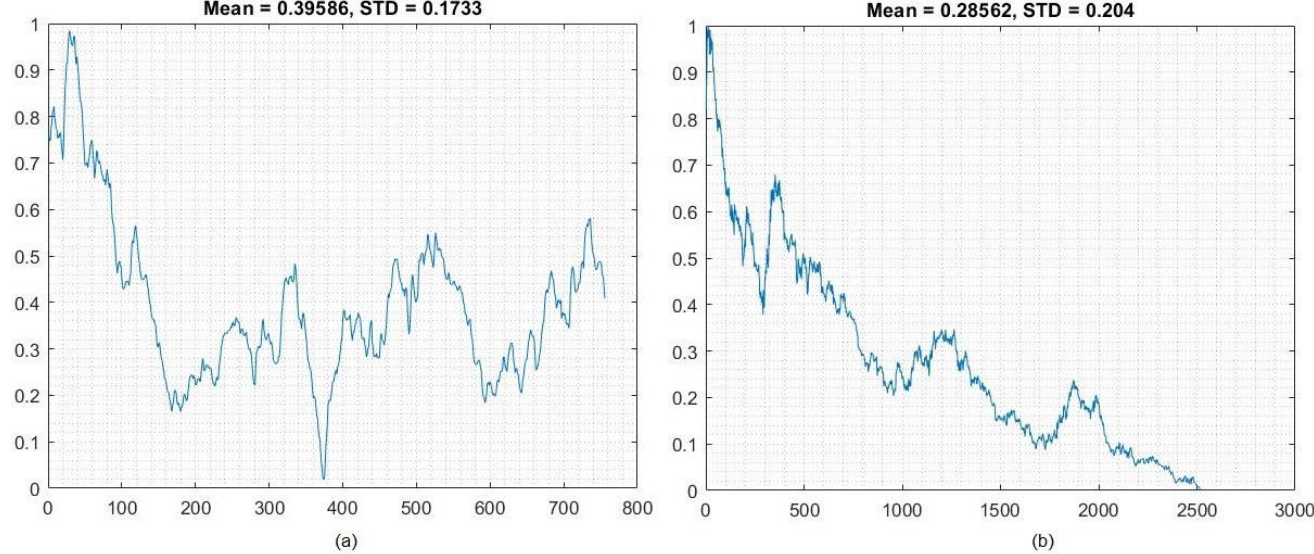
Figure 2. Normalization of ( a ) Tesla and ( b ) Apple data.